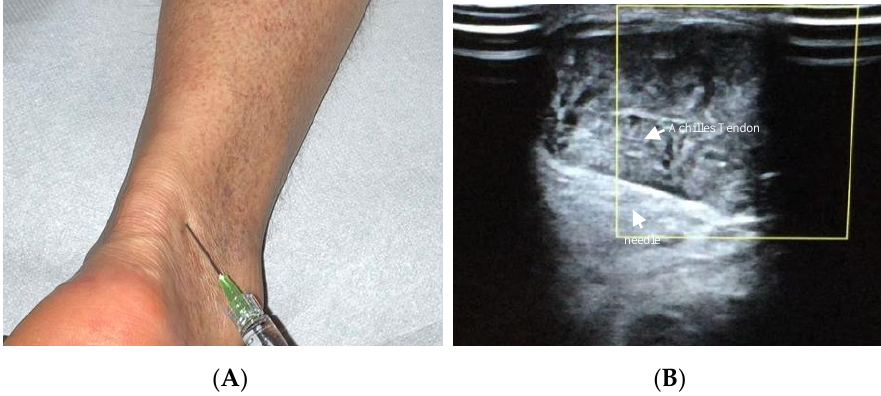
Figure 3. ( A ) Injection of HA in a dorsolateral approach of Achilles tendon; ( B ) US visualisation (5–12 MHz linear probe and PRF set at 0.5 kHz) of the needle (22-gauge) introduced at a 30-degree angle in the mesotendon, with the probe in a transverse plane.